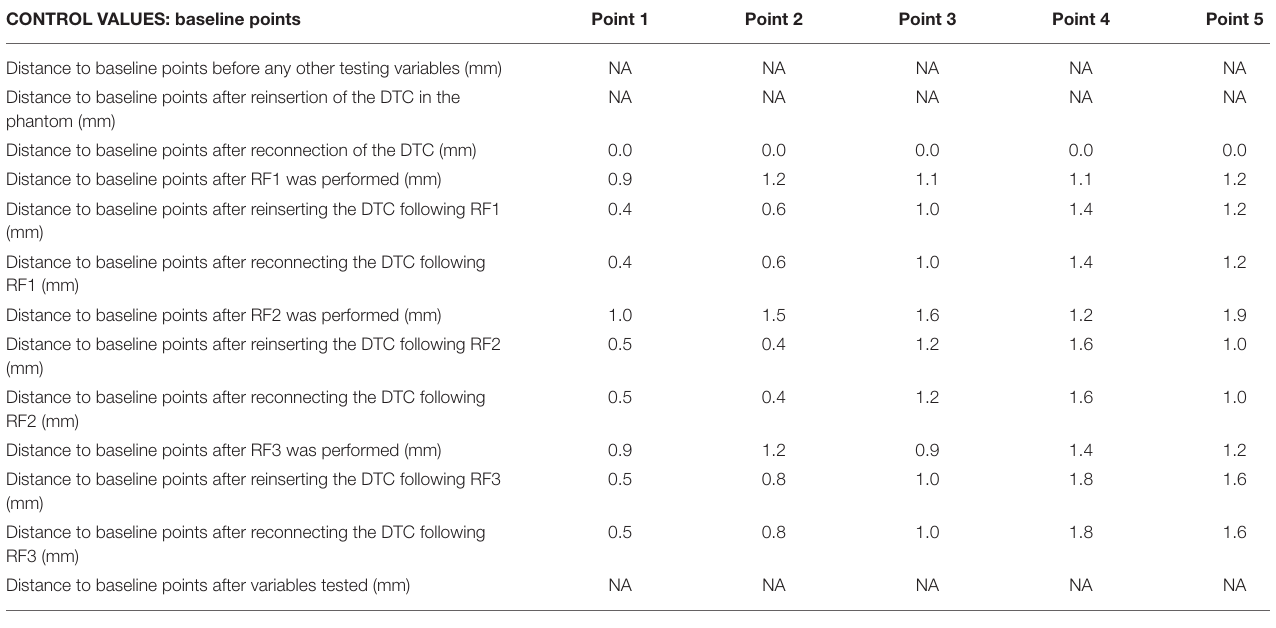
TABLE 2 | DiamondTemp catheter location after RF1, RF2 or RF3 for all setups tested. CONTROL VALUES: baseline